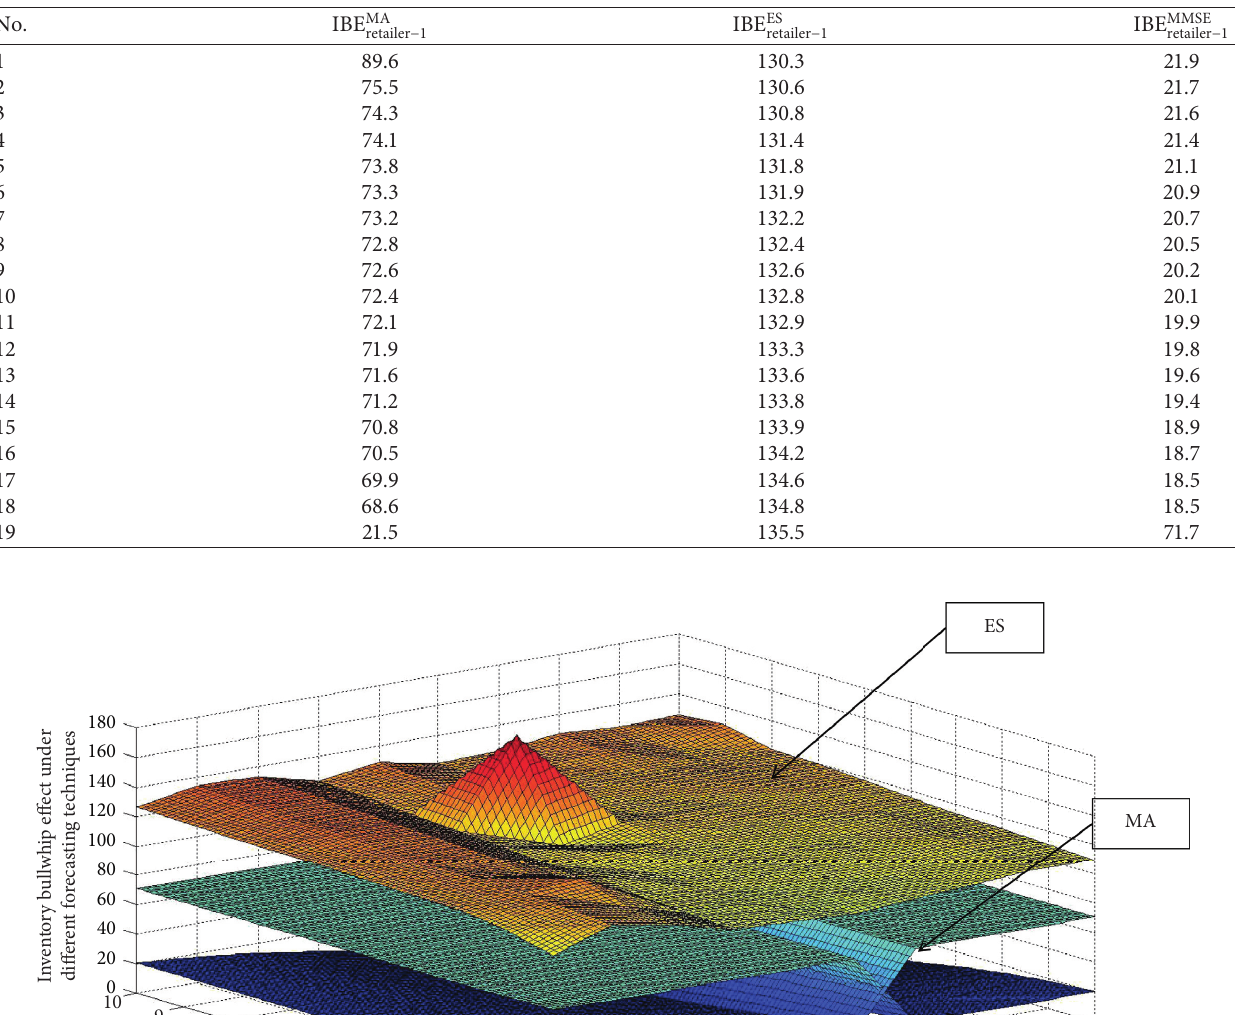
Table 7: The simulation result.